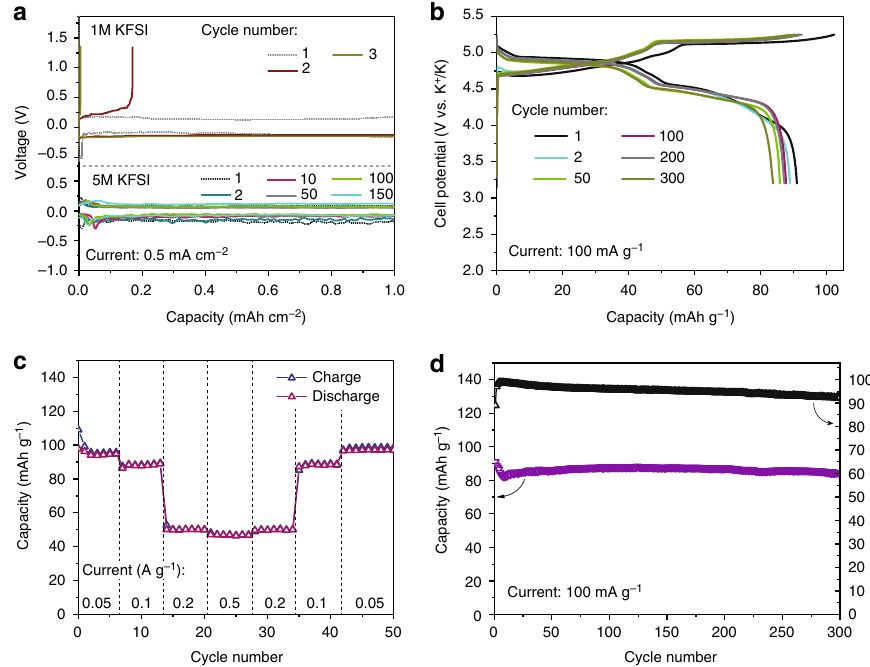
Fig. 5 Electrochemical performance of KFSI-graphite DIB. a Galvanostatic plaiting (discharge) and stripping (charge) curves of coin-type cells composed of potassium metal as an counter and reference electrode and aluminum as an working electrode in 1 and 5 M KFSI/EC/DMC electrolyte, measured at areal current densities of 0.5 mA cm − 2 (with areal capacity limitation of 1 mAh cm − 2 ). b – d Galvanostatic charge – discharge voltage curves ( b ), rate capability measurements ( c ), and cycling performance of KFSI-graphite DIB ( d